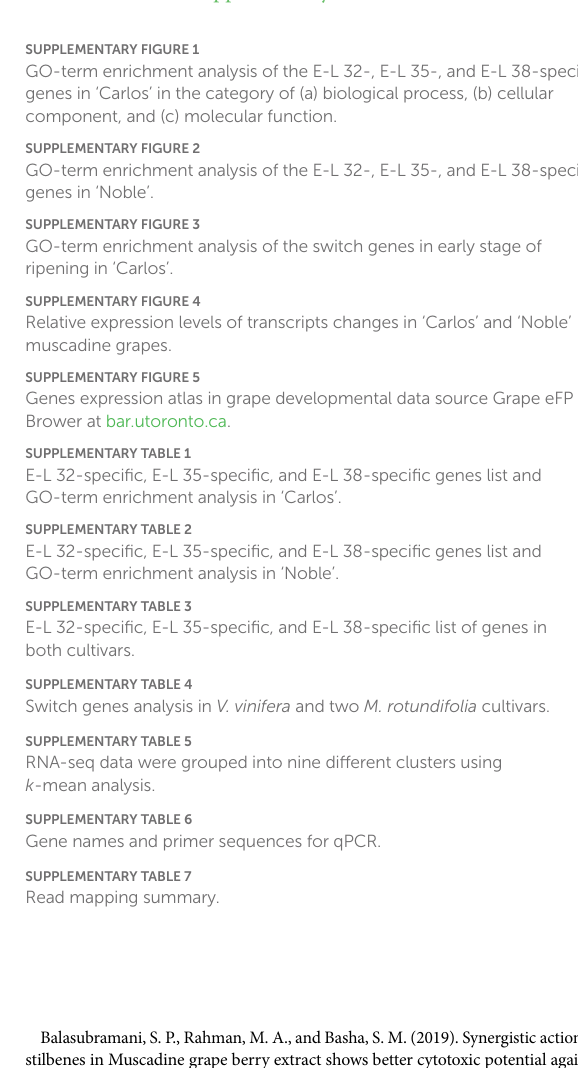
SUPPLEMENTARY TABLE 6 Gene names and primer sequences for qPCR. SUPPLEMENTARY TABLE 7 Read mapping